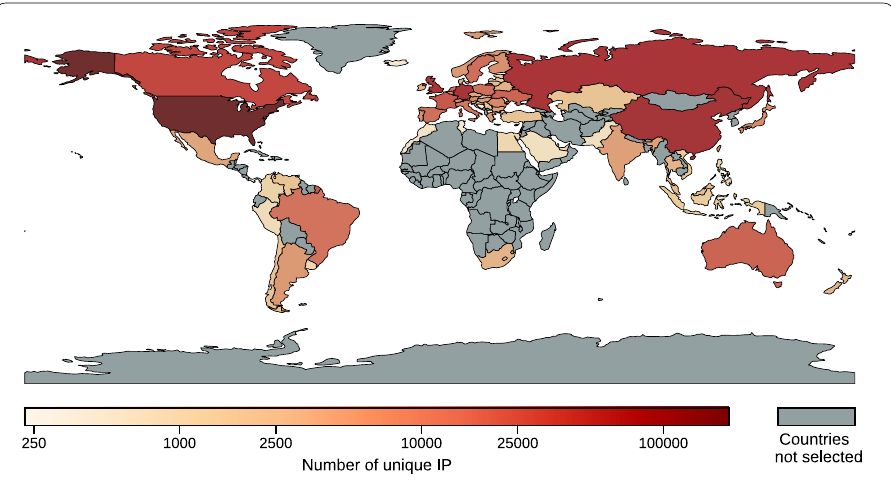
Figure 1 Map representing the number of new IP addresses appeared in the Bitcoin system by country in the time interval from 2012-09 to 2014-05, for the countries selected for our study (see the list in Table 9). Countries have been selected based on the activity (IP and clients) as explained in Sect.